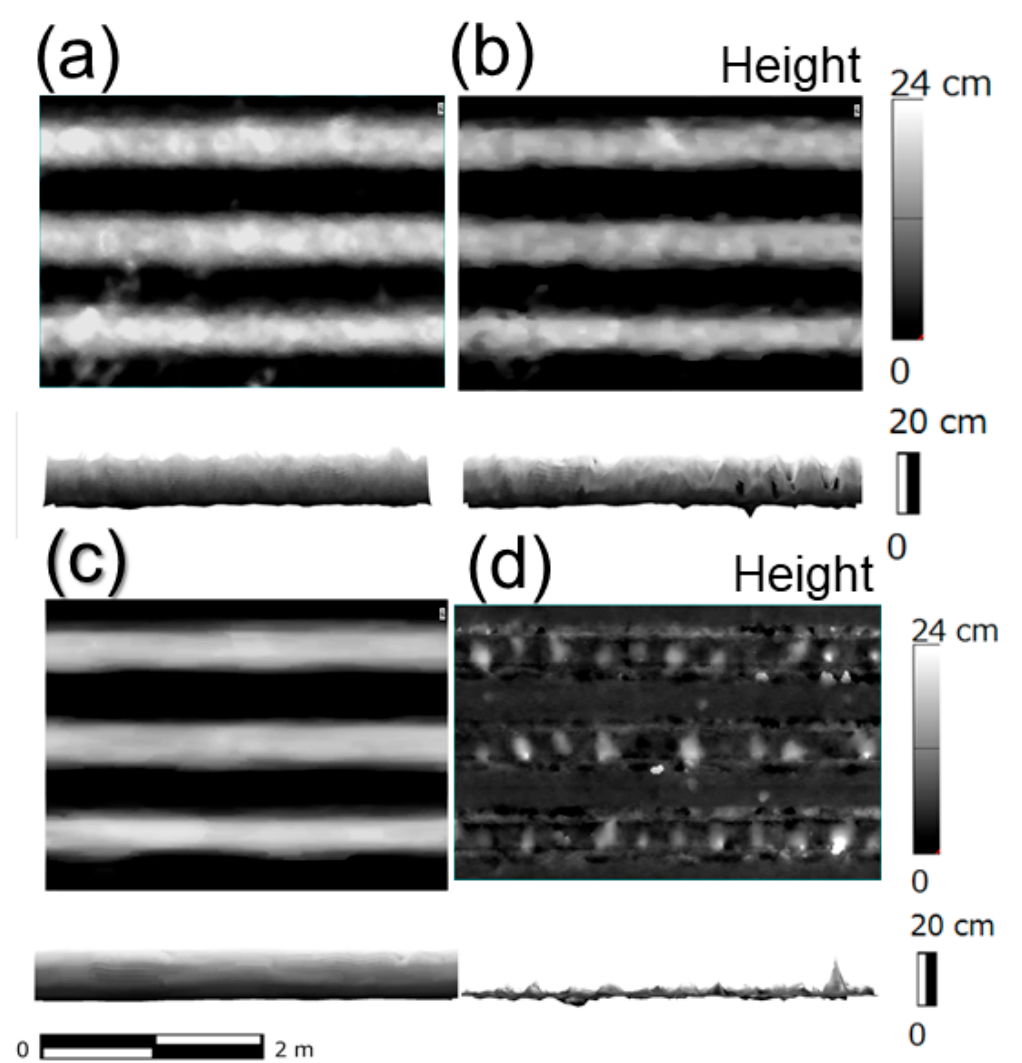
Figure 5. The steps of DTM and PHM generation in ridge cultivation. ( a ) DSM; ( b ) DTM after 5 × 5 enlargement filter process; ( c ) DTM smoothed by 7 × 1 rectangular median filter; ( d ) PHM generated from a–c.